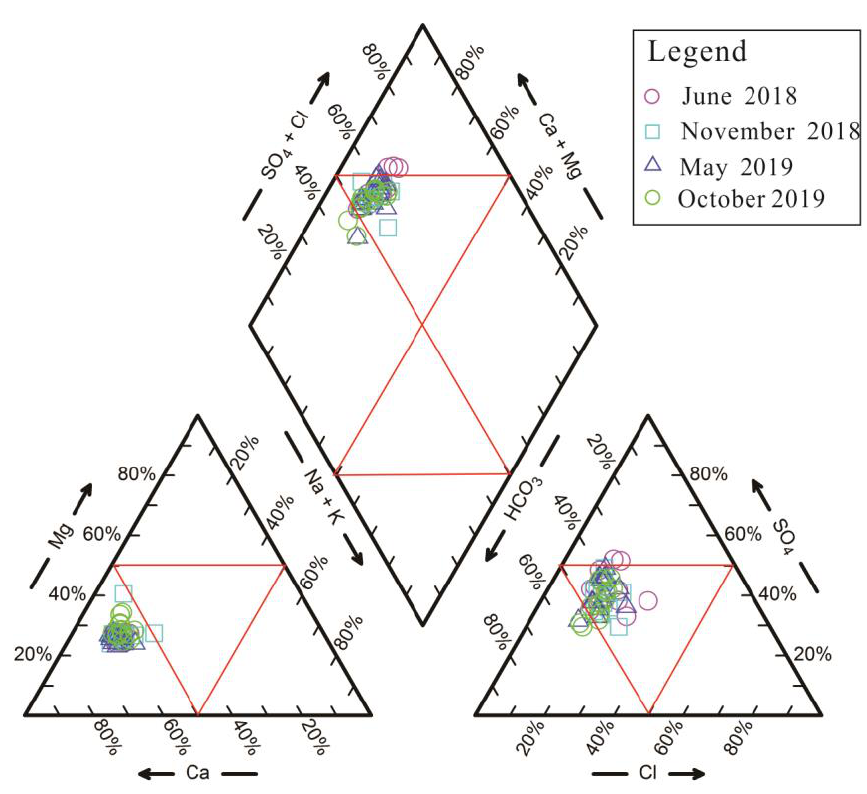
Figure 4. Piper diagram of groundwater in four stages of the recharge area.